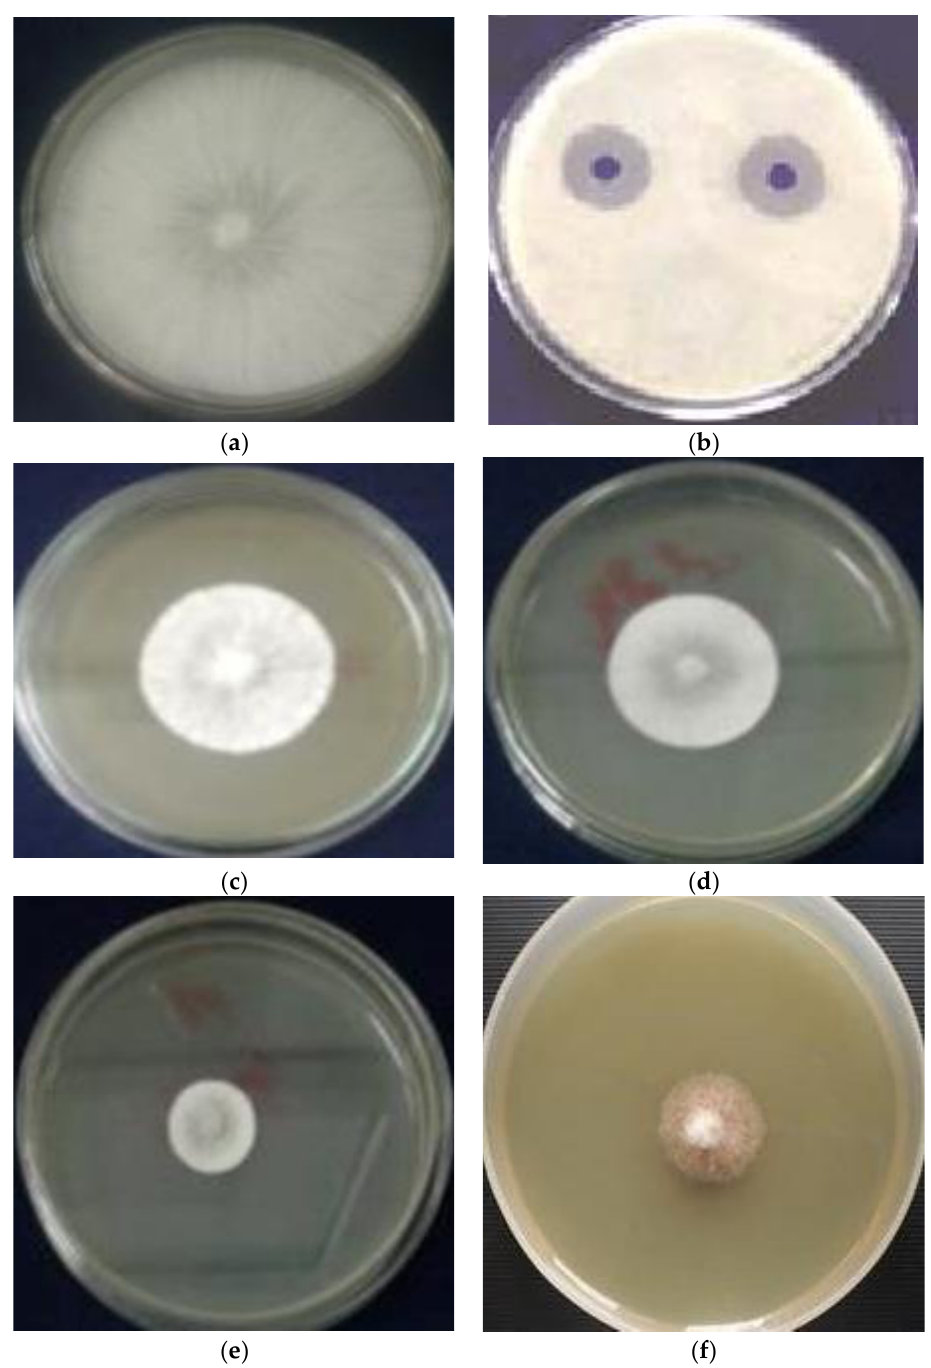
Figure 5. The effect of Berberis vulgaris extracts on fungal colony growth: ( a ) negative control; ( b ) positive control; ( c ) P. verecossum ;( d ) A. parasiticus ; ( e ) A. carbomareous; and ( f ) F. proliferatum .